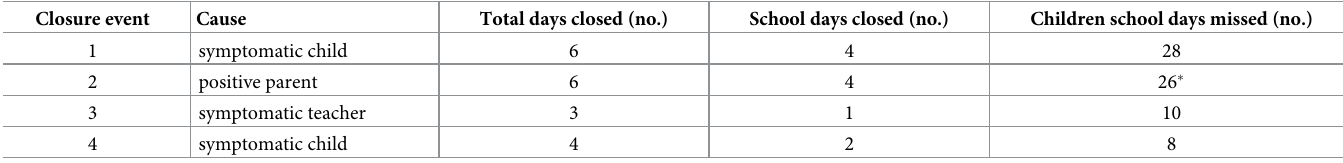
Table 4. Child and family center